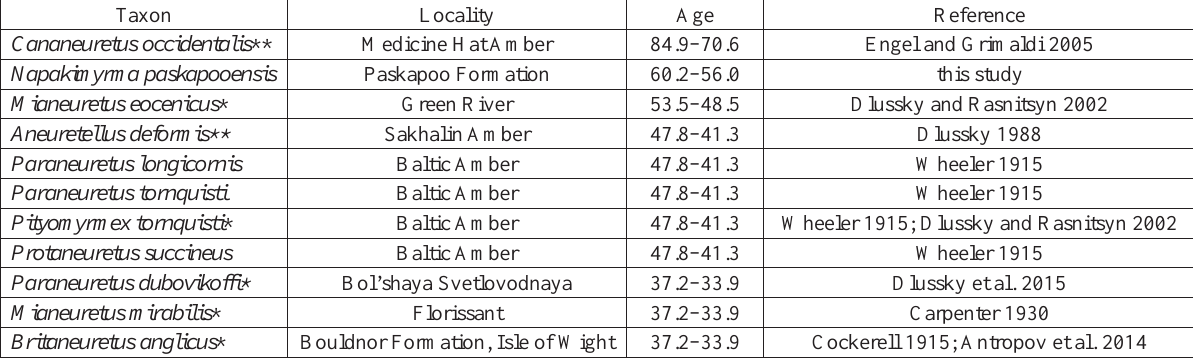
Table 1. Described fossil anueretine taxa. * indicates large uncertainty regarding subfamily placement based on assumption of long anterior peduncle as a synapomorphy for Anueretinae; ** indicates plausible but unconfirmed